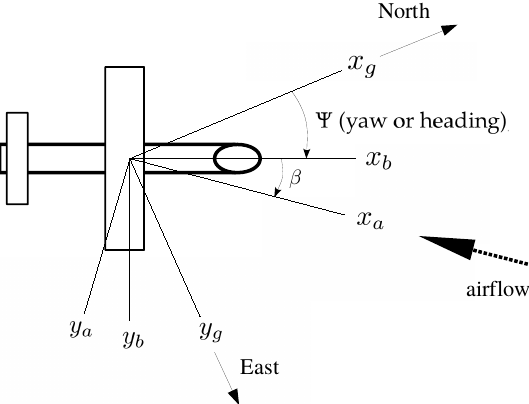
Figure 4. Top view of the wind measurement with the indices a, b, and g representing, respectively, the aerodynamic, body, and geodetic coordinate systems. Ψ is the yaw angle or true heading of the sUAV and β is the side slip angle between the aerodynamic and body-fixed coordinate